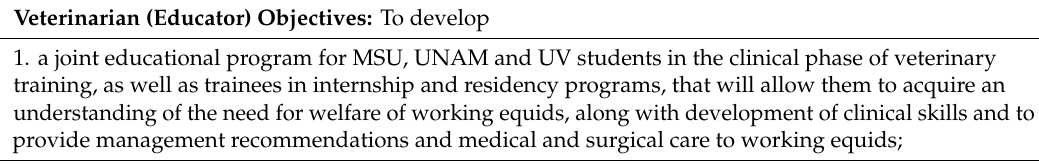
Table 1. Faculty and student objectives for the Equine Welfare in Practice